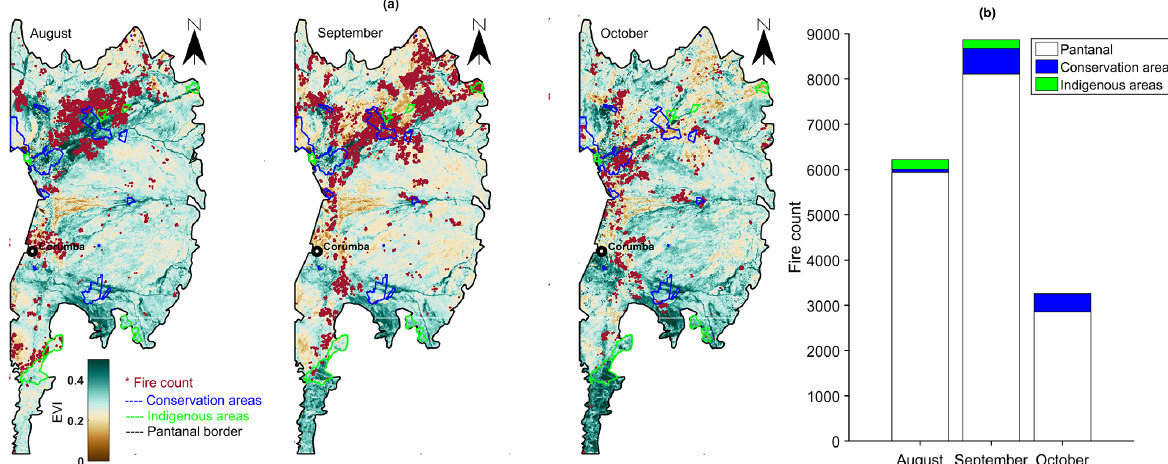
Figure 5. (a) Fire count distribution over Pantanal for August, September, and October of 2020 using the enhanced vegetation index (EVI) as the background. (b) Monthly (August, September, and October) distribution of fire count over Pantanal and over conservation and indigenous areas located within the biome.